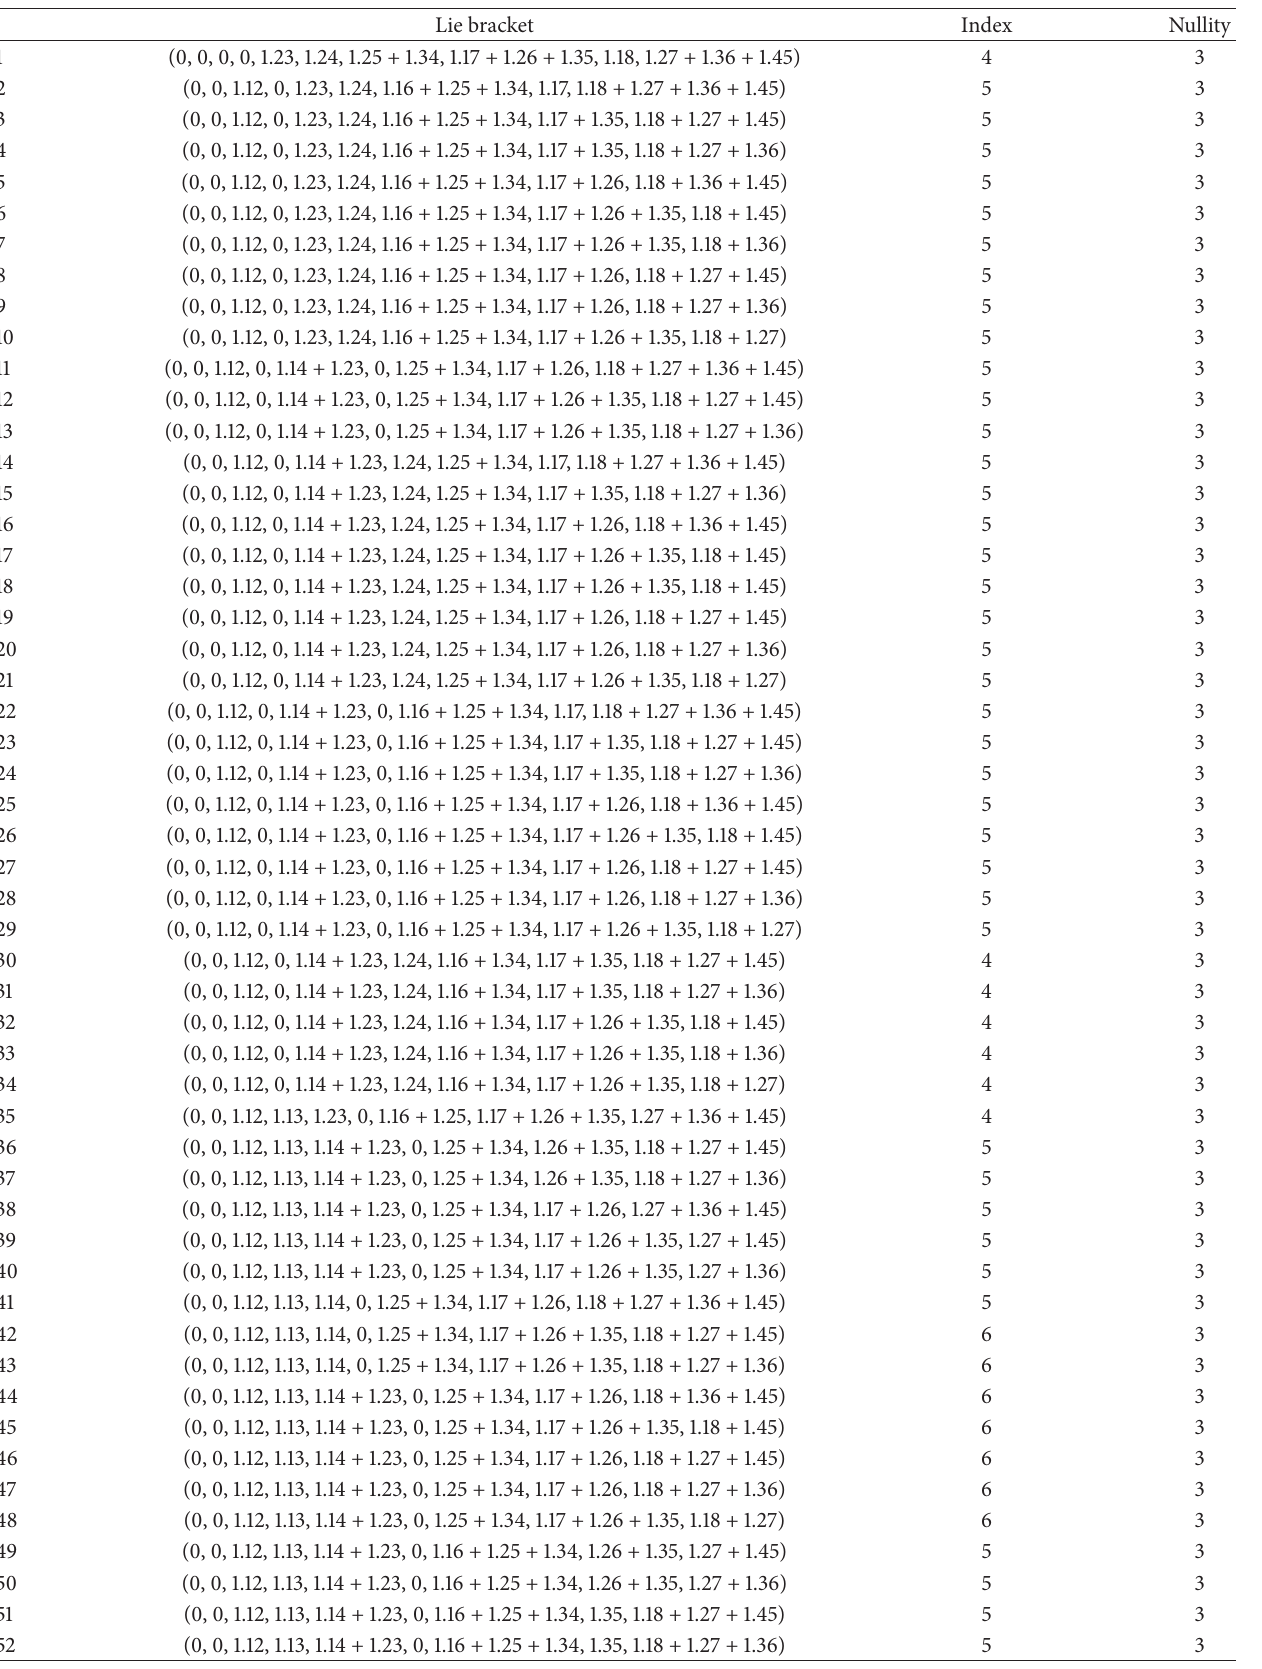
Table 7: The 9-dimensional nilsoliton metric Lie algebra candidates of nullity